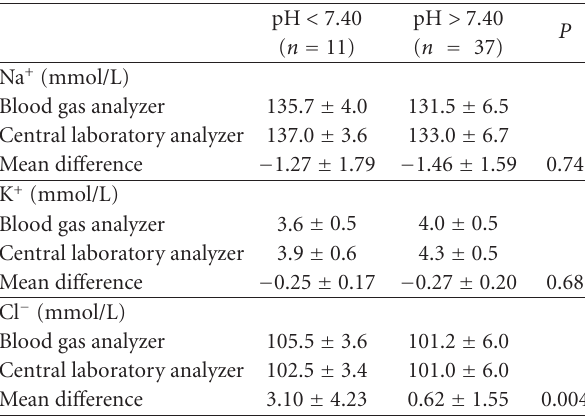
Table 1: Mean values and mean di ff erences in electrolyte con- centrations measured simultaneously by two analyzers for samples from acidic patients (pH < 7.40) or alkalemic patients (pH > 7.40).